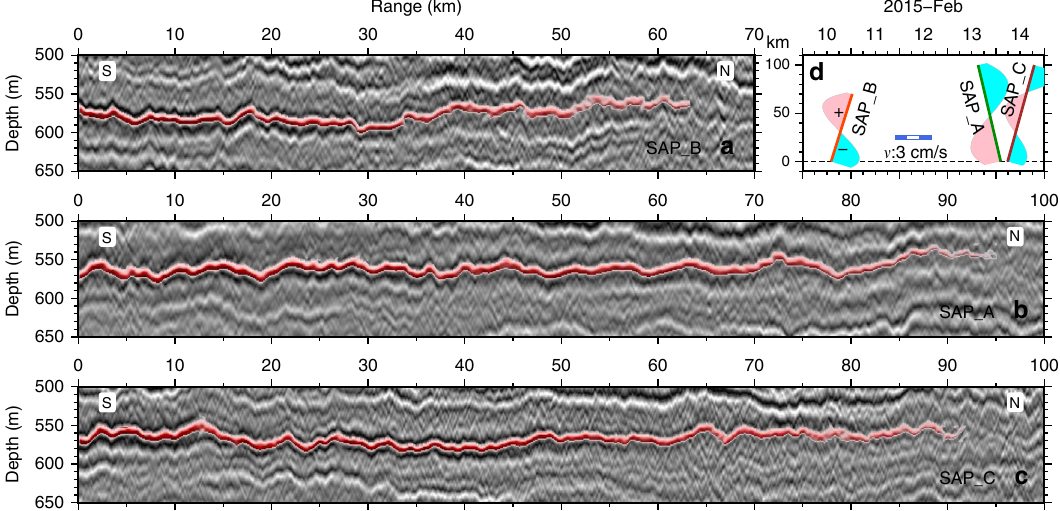
Fig. 3 Enlargements of the target re fl ections (red) at ~560 m depth in Fig. 2. Three time-lapse seismic sections a SAP_B, b SAP_A, c SAP_C, and d their acquisition time and the predicted meridional component of the tidal current. The blue and pink fi lled areas represent the amplitude of the meridional component of the tide relative to the scale in the centre of the plot NATURE COMMUNICATIONS| (2019) 10:4674